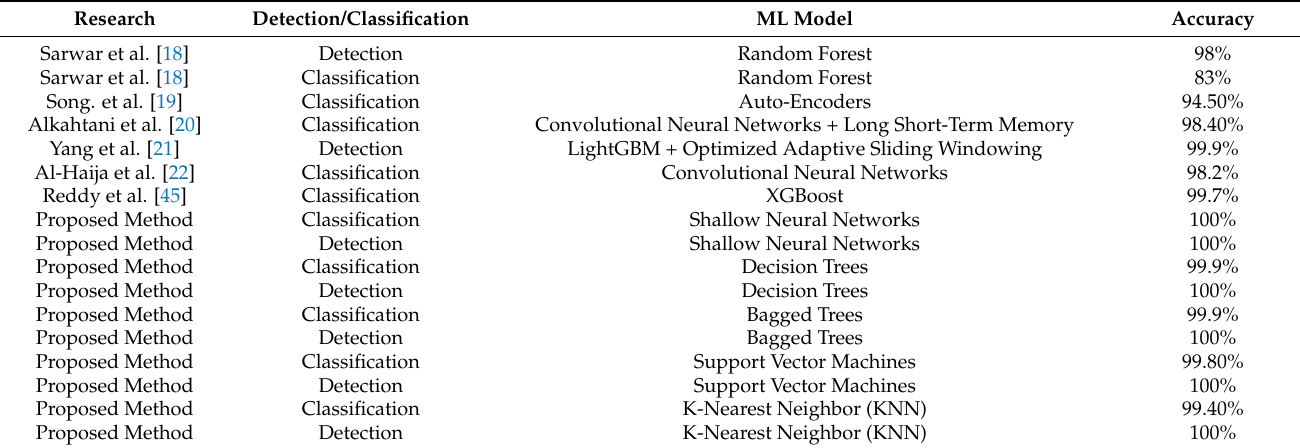
Table 6. Comparing our ML models’ accuracy with existing ML models’